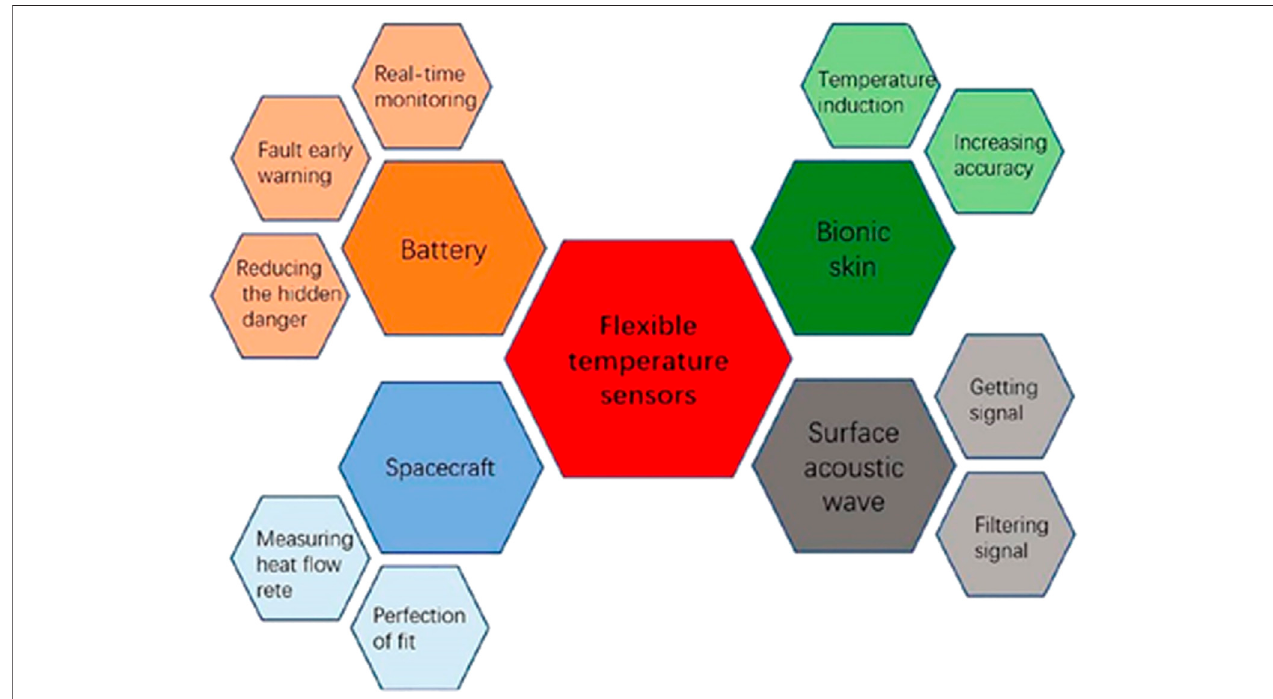
FIGURE 7 | Applications of flexible temperature